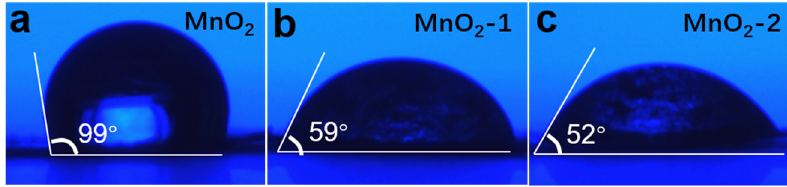
Figure 3. Contact angle photos of the electrolyte on α‐ MnO 2 ( a ), MnO 2 ‐ 1 ( b ), and MnO 2 ‐ 2 ( c ).